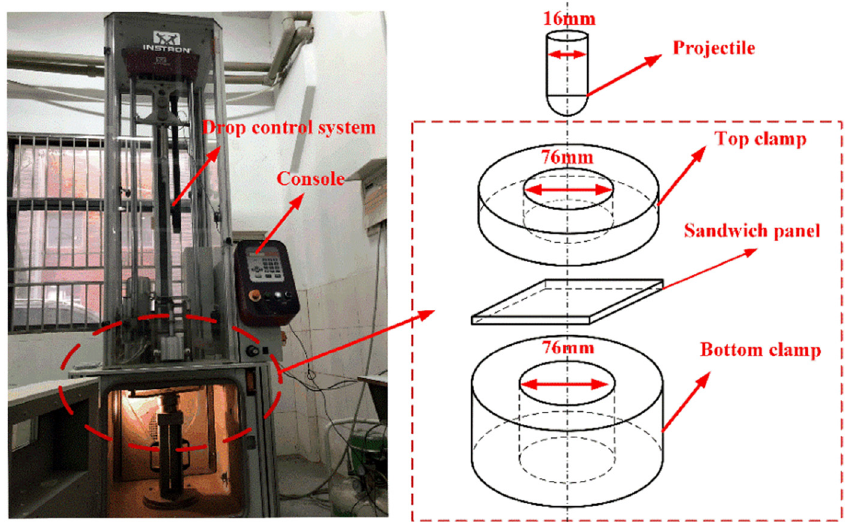
Figure 3: The device of the impact